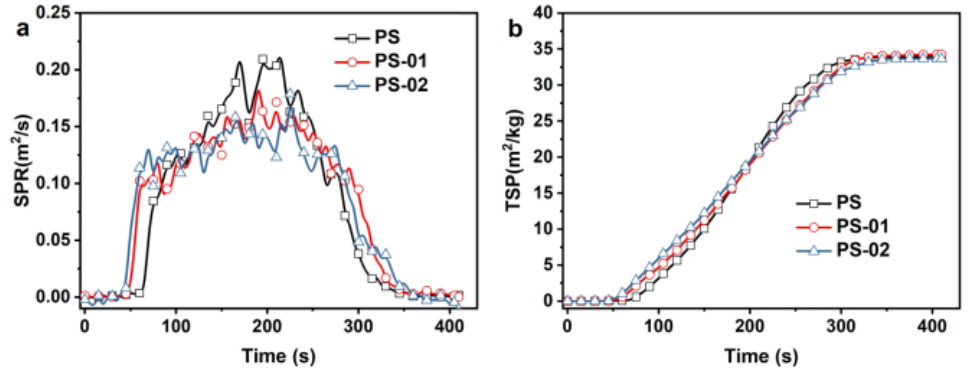
Figure 8. SPR ( a ) and TSP ( b ) curves of PS and its blends under a heat flux of 35 kW/m 2 . Table 3. Cone calorimeter test data for PS and its blends.